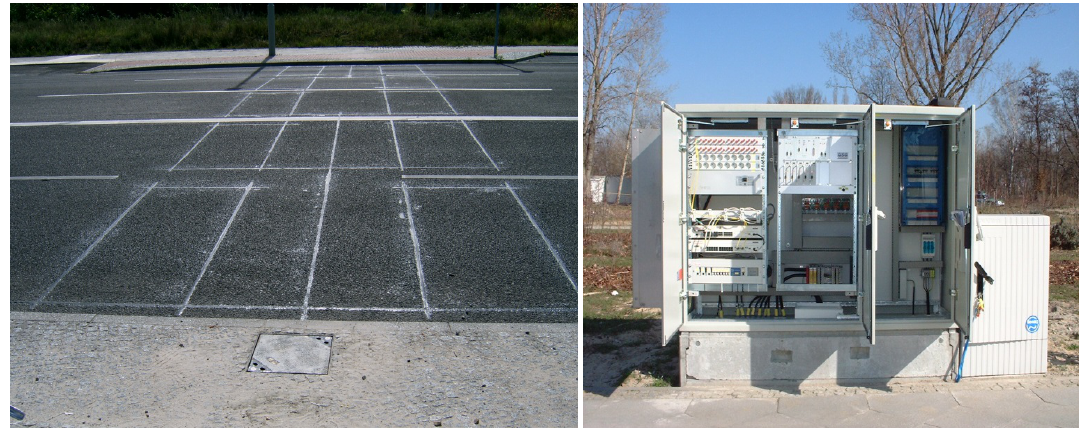
Figure 3: Inductive loops (left) and outstation (right).